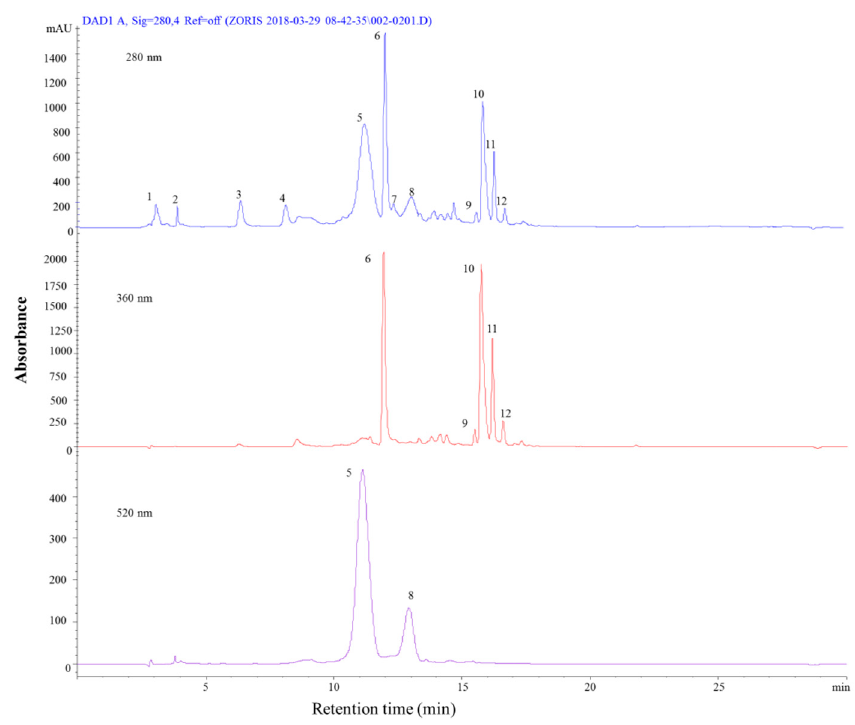
Figure 3. HPLC-PDA chromatograms of red chicory recorded at 280, 360 and 520 nm. Table 3. Characterization of phenolic compounds in red chicory via positive mass spectrometry LC- Mass Spectrometry